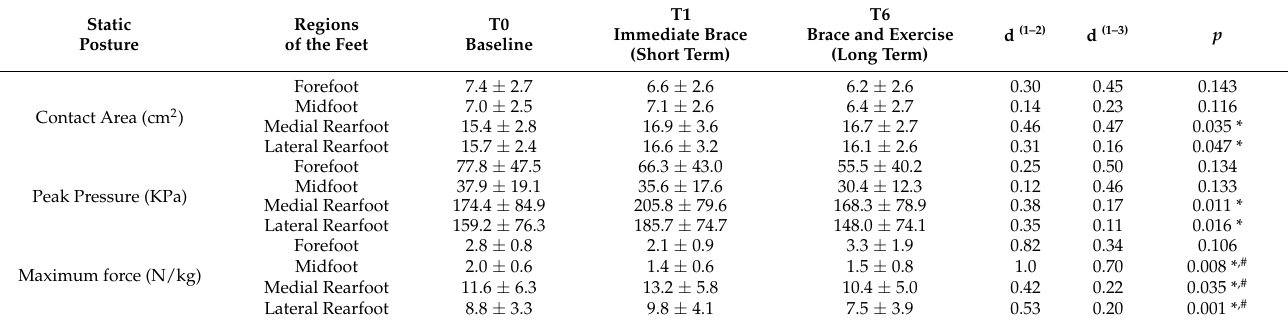
Table 7. Comparisons of static posture between the different timepoints: T0—baseline, T1—after immediate use of the spinal orthopedic brace (short term, 24 h) and T6 after six months using the brace associated with exercises (long term) specific in adolescents with idiopathic